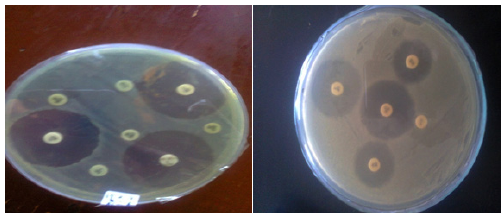
Fig. 1. Disc diffusion method with inhibition zone for some antibiotics against S. aureus